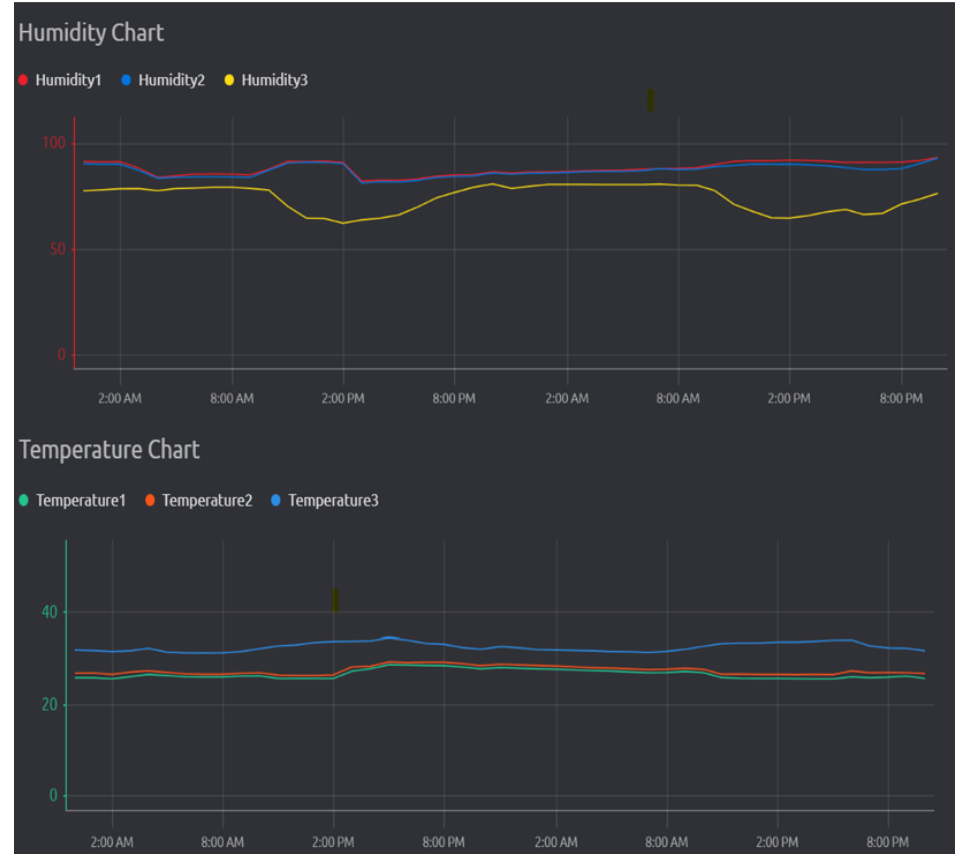
Figure 8. System generated humidity chart and temperature chart for the mushroom cultivation chamber.